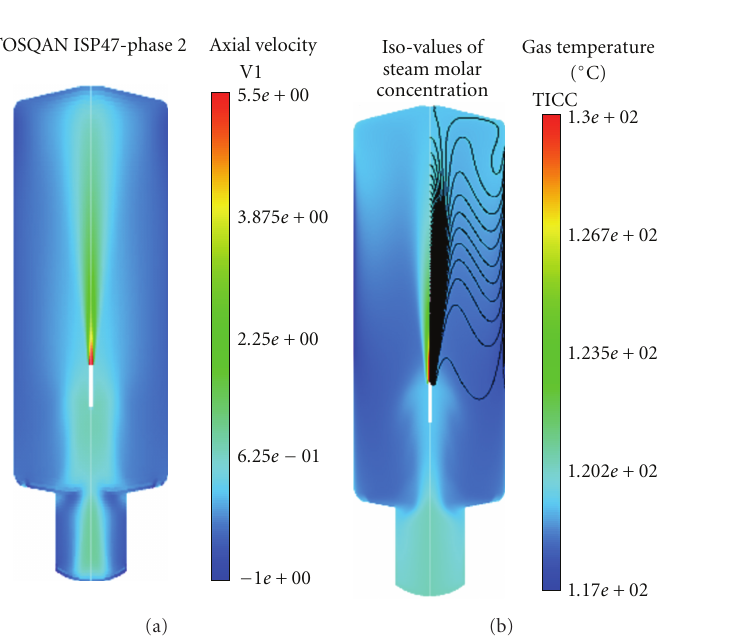
Figure 2: Fields of axial velocity, gas temperature, and isovalues of steam molar concentration with NEPTUNE CFD.